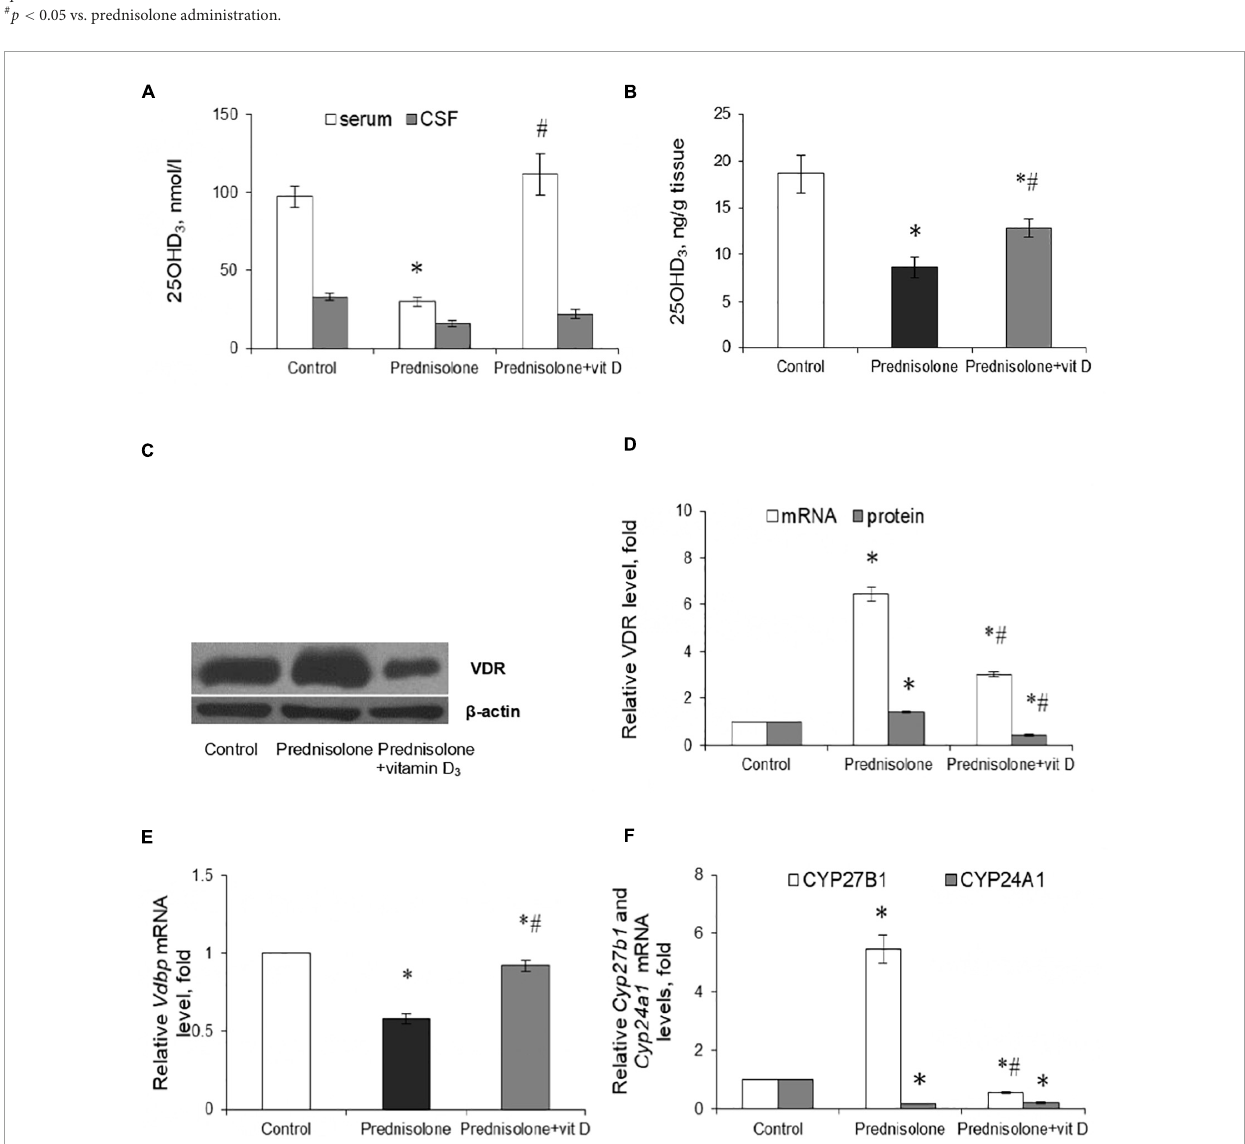
FIGURE2 Vitamin D 3 circulating pool and the state of vitamin D 3 -auto/paracrine system in the brain tissue. 25OHD 3 concentration in the serum, cerebrospinal fluid (A) and brain homogenates (B) were measured by ELISA ( n = 20). VDR protein (C,D) and mRNA (D) levels were determined by western blotting and quantitative RT-PCR respectively in rat brain tissue of three animal groups: 1—control; 2—prednisolone administration; 3—prednisolone and vitamin D 3 administration ( n = 8 rats/group). Representative immunoblots are shown near the bar charts (C) . Cyp27b1 (E) and Cyp24a1 (F) mRNA levels were assessed by quantitative RT-PCR. All protein levels were normalized to β -actin and mRNA levels—to Gapdh expression. All data are presented as mean ± SD of three independent experiments done in triplicate; ∗ p < 0.05 denotes significance compared with control, # p < 0.05 denotes significance compared with prednisolone